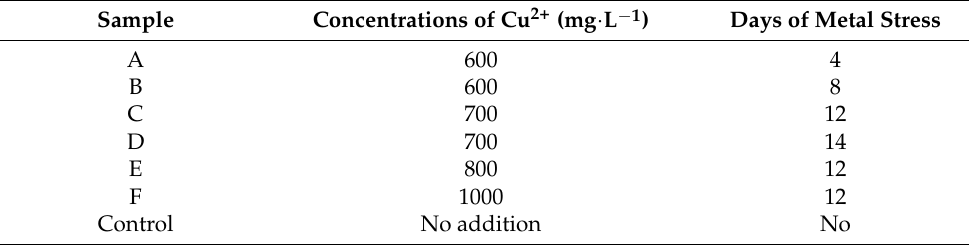
Table 1. Domesticated Y. lipolytica strains for